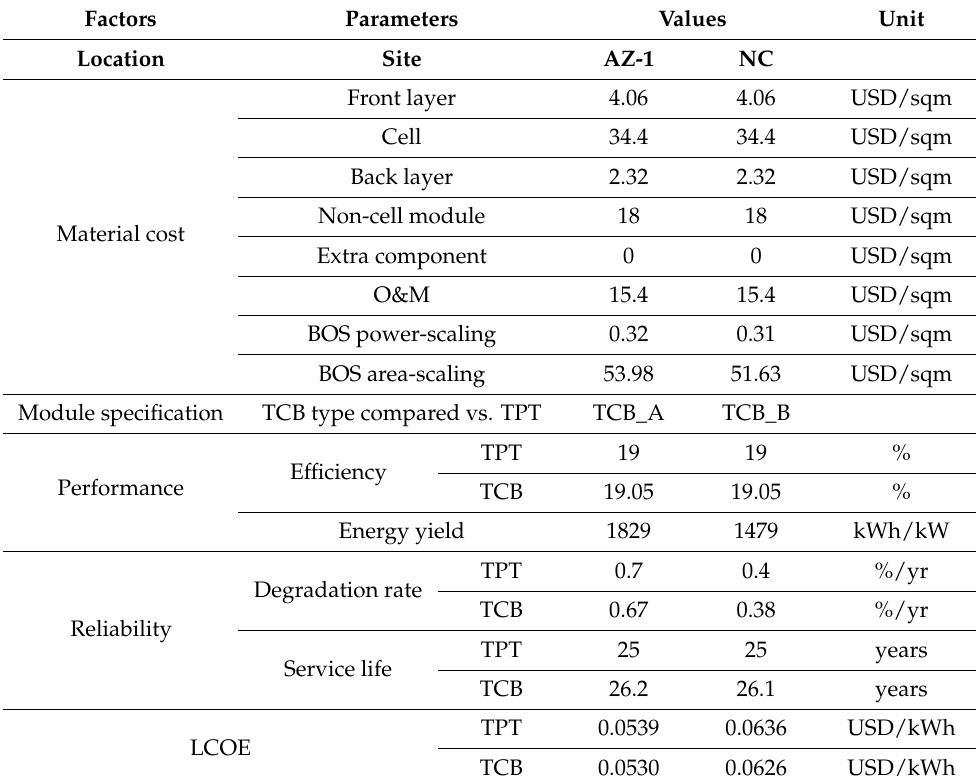
Table 5. Impact on various factors used in comparative LCOE analysis.